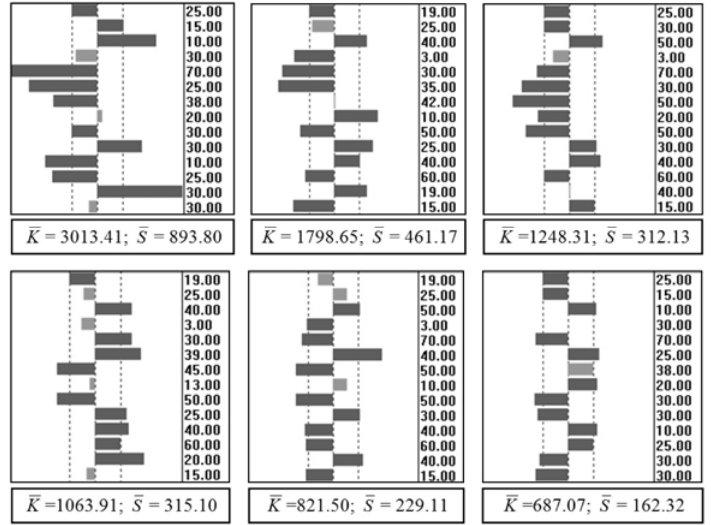
Fig. 2. Intermediate